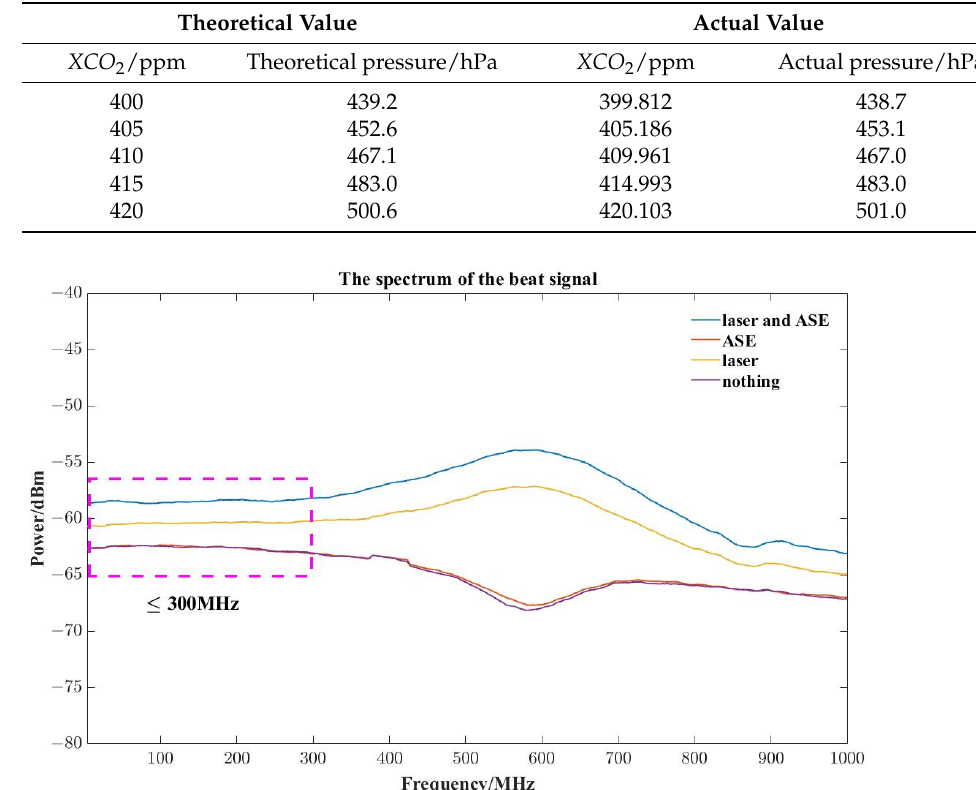
Figure 11. The spectrum of the beat signal.